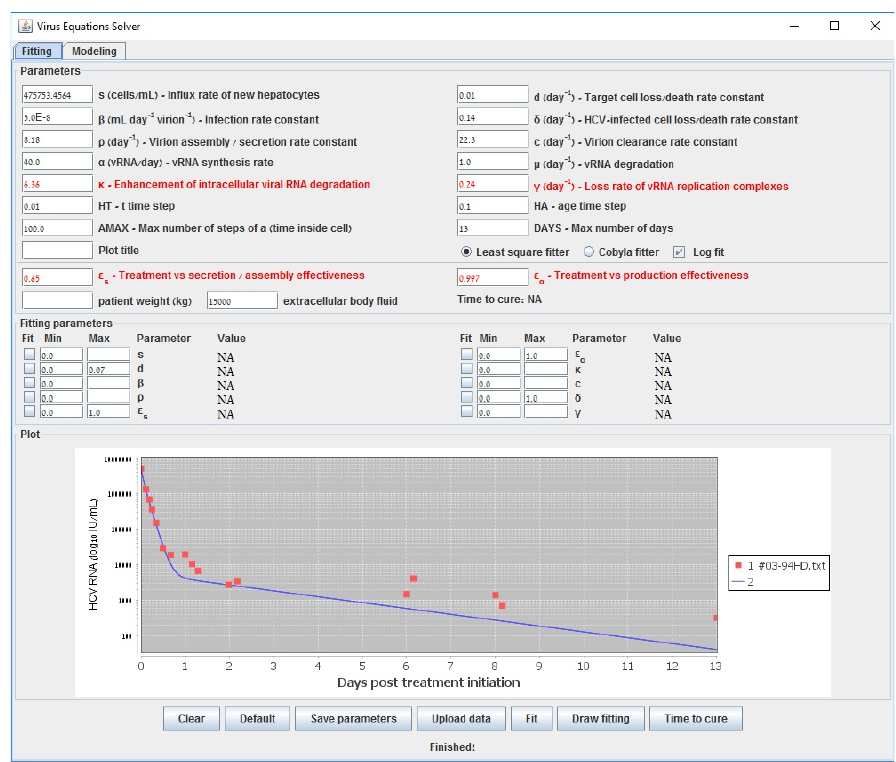
Figure 2. Start fit that emanates from data of a patient reported in [48]. The fitting curve corresponds to default parameters before fitting with our methods. The multiscale model is used.